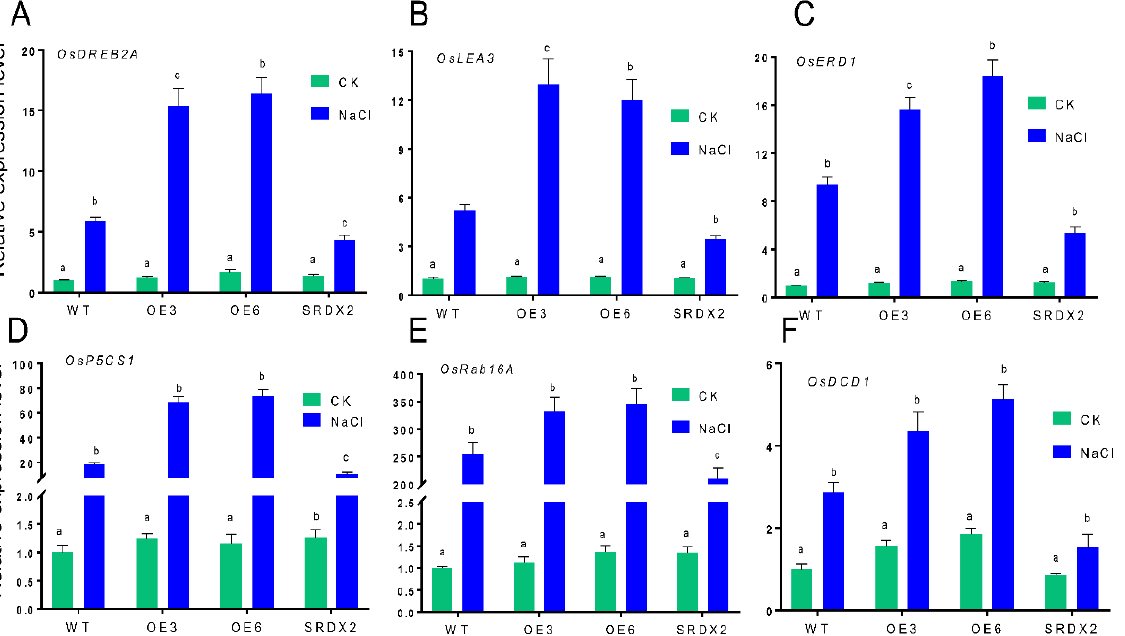
Figure 8. Expression levels of some salt-responsive genes and hydrogen sulfide synthesis gene in wild-type and transgenic plants. ( A ) OsDREB2A . ( B ) OsLEA3 . ( C ) OsERD1. ( D ) OsP5CS1. ( E ) OsRab16A. ( F ) OsDCD1 . Total RNA was extracted from 21-day-old rice seedlings grown under control and salt-stress (350 mM NaCl) conditions for 4 days. Statistical analyses were performed by a two-way ANOVA, followed by a Tukey’s multiple comparison test. Different letters indicate significant differences at p < 0.05.